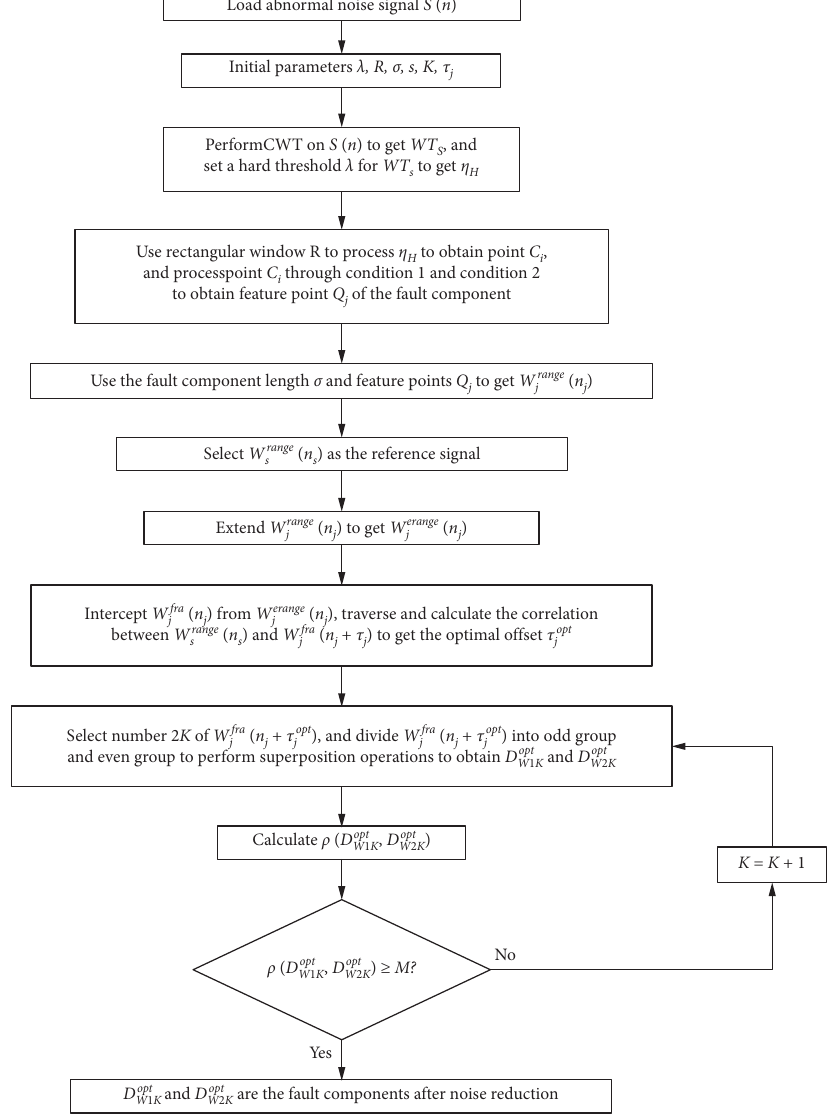
Figure 4: The flowchart of the adaptive noise reduction method of automobile engine acoustic signal based on improved DSM and